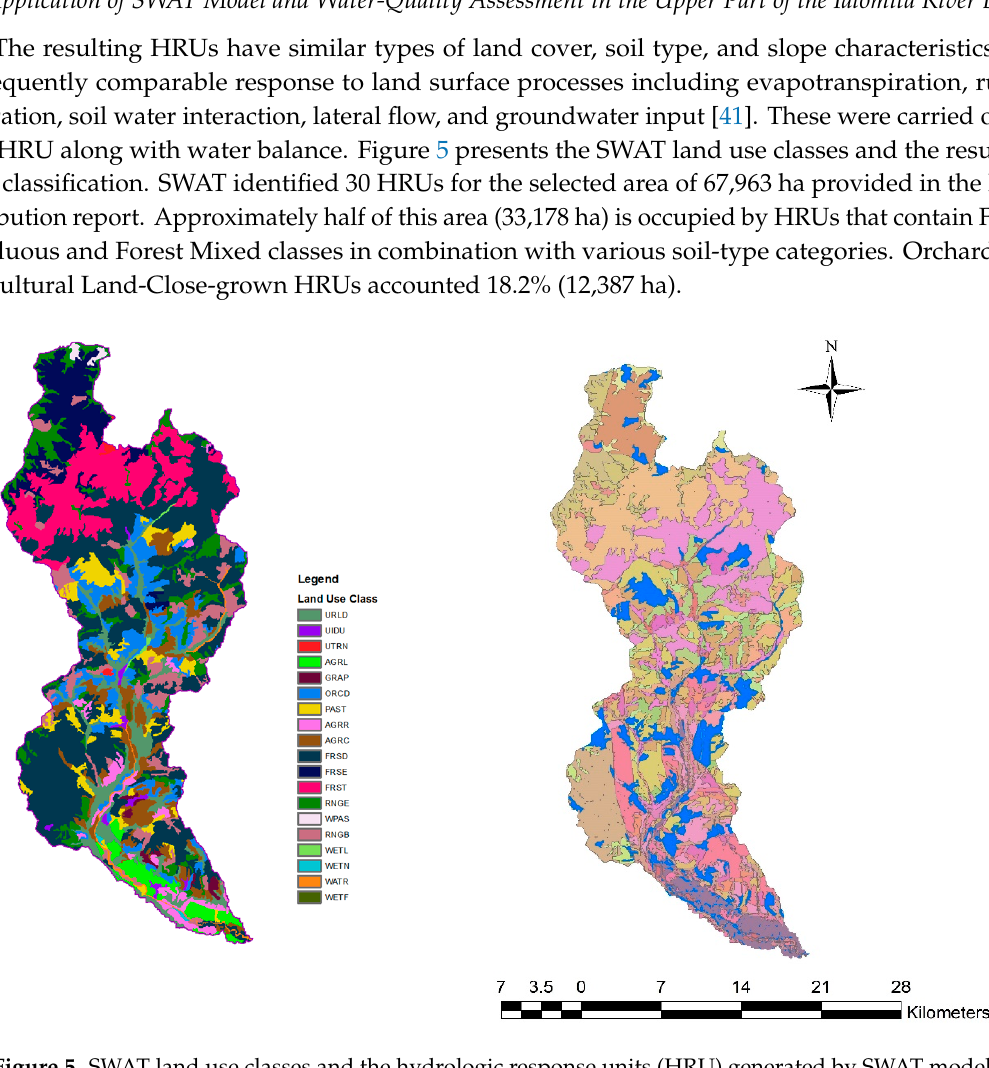
Figure 5. SWAT land use classes and the hydrologic response units (HRU) generated by SWAT model (yellow area in Figure